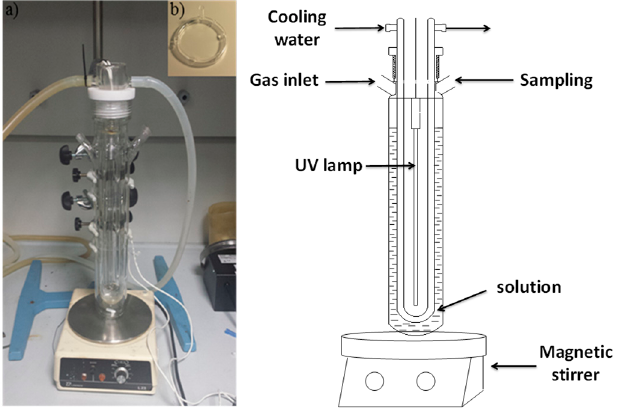
Figure 3. Glass photoreactor picture and